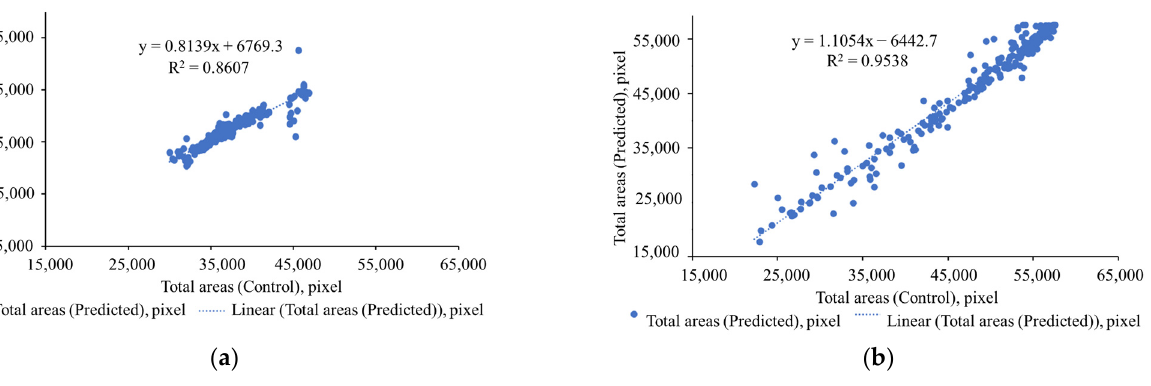
Figure 16. Comparative analysis of leaf/canopy pixel monitoring: ( a ) thermal RGB and ( b ) RGB.